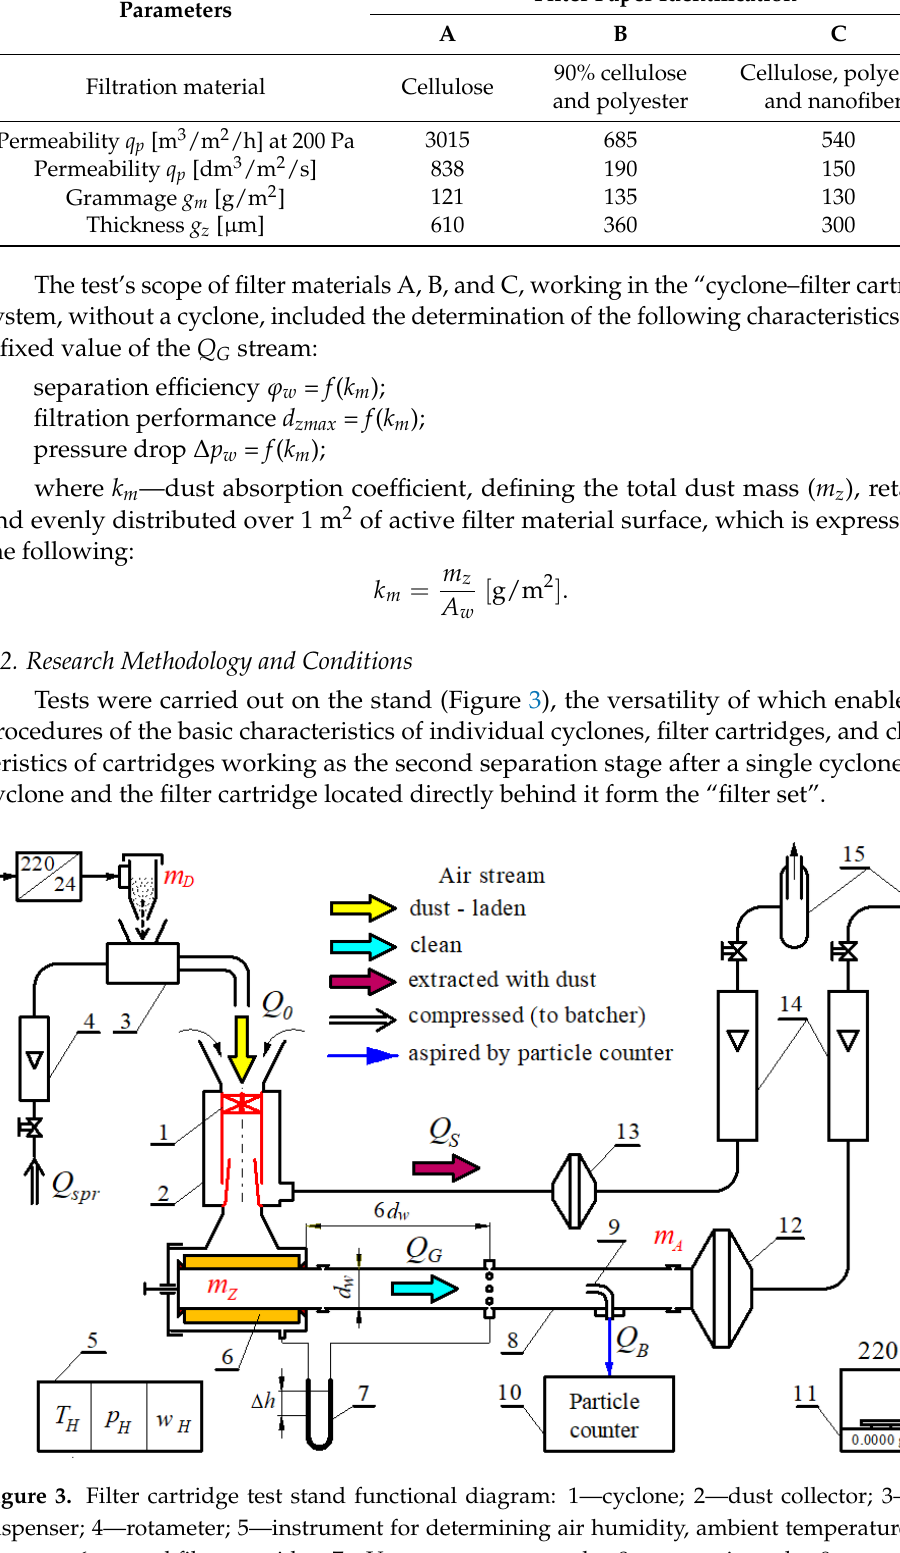
Table 1. Tested filtration materials parameters, according to the manufacturer’s data. Parameters